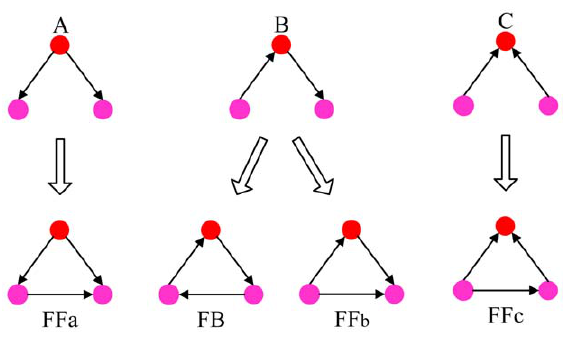
Figure 1. Three possible unclosed triples and four basic closed triples for a focal node (red). The basic closed triples correspond to one feedback ( FB ) loop and three feedforward ( FF ) loops. The three feedforward loops differ in the indegree k in of the focal node: k in ~ 0 for FF a , k in ~ 1 for FF b and k in ~ 2 for FF c . The numbers of the three feedforward loops are equal because every FF a loop from the perspective of the focal node constitutes a FF b loop and a FF c loop from the perspective of the another two nodes, but the loops may